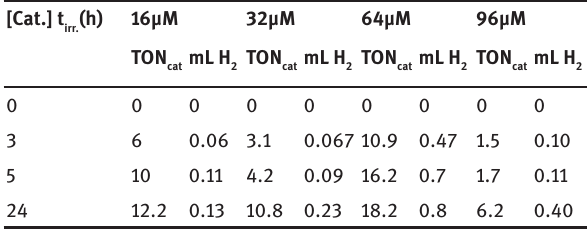
Table 3: Hydrogen evolution with 0.25mM [ReBr(CO) AcOH, 1M TEOA, DMF and argon with different concentrations of Catalyst ( 2 ), λ>400 nm ( after 0-24 h irradiation) at room temperature. [Cat.] t (h) irr.